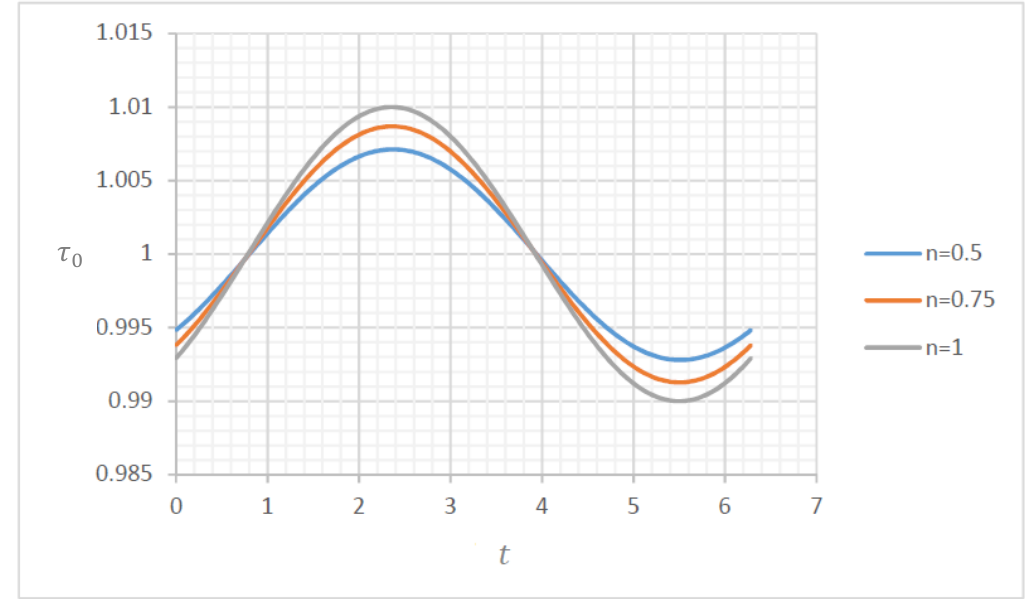
Figure 3. Wall shear stress for Ω = 100, Re = 1, ε = Figure 3. Wall shear stress for  = 100 , 𝑅𝑒 = 1 , 𝜀 = 0.1 .